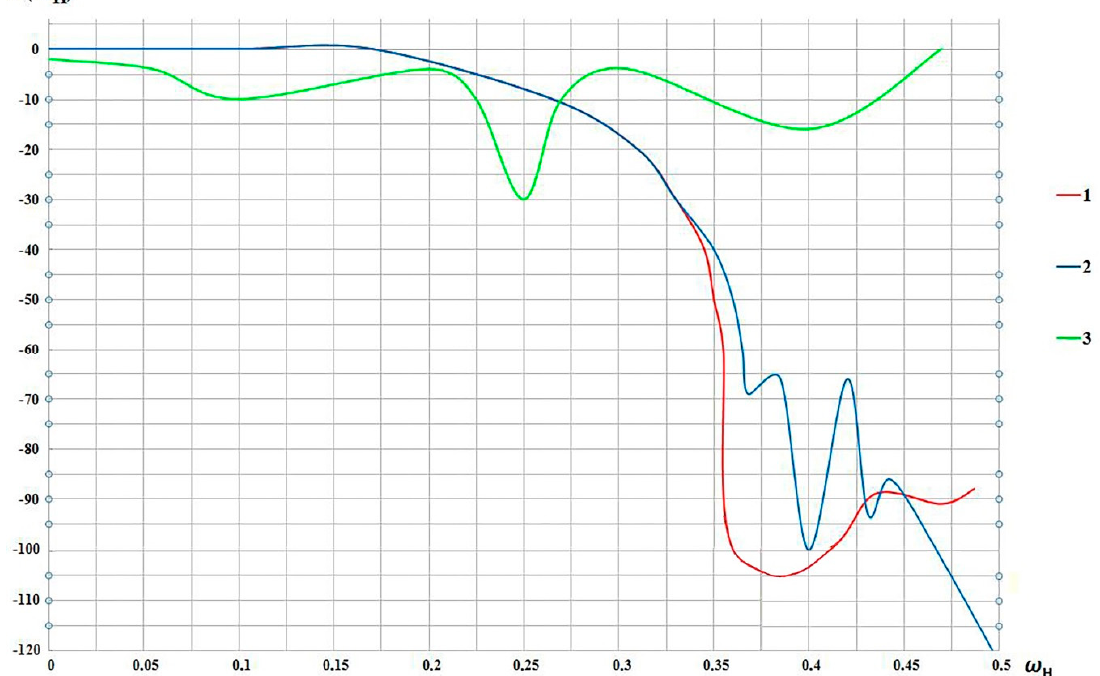
Figure 4. Frequency responses of the DF: 1—frequency response (FR) of the DF with the representation of its coefficients in the algebra of the finite ring; 2—FR of the positional DF with 16-bit coefficients; 3—FR of the positional DF with 8-bit coefficients.